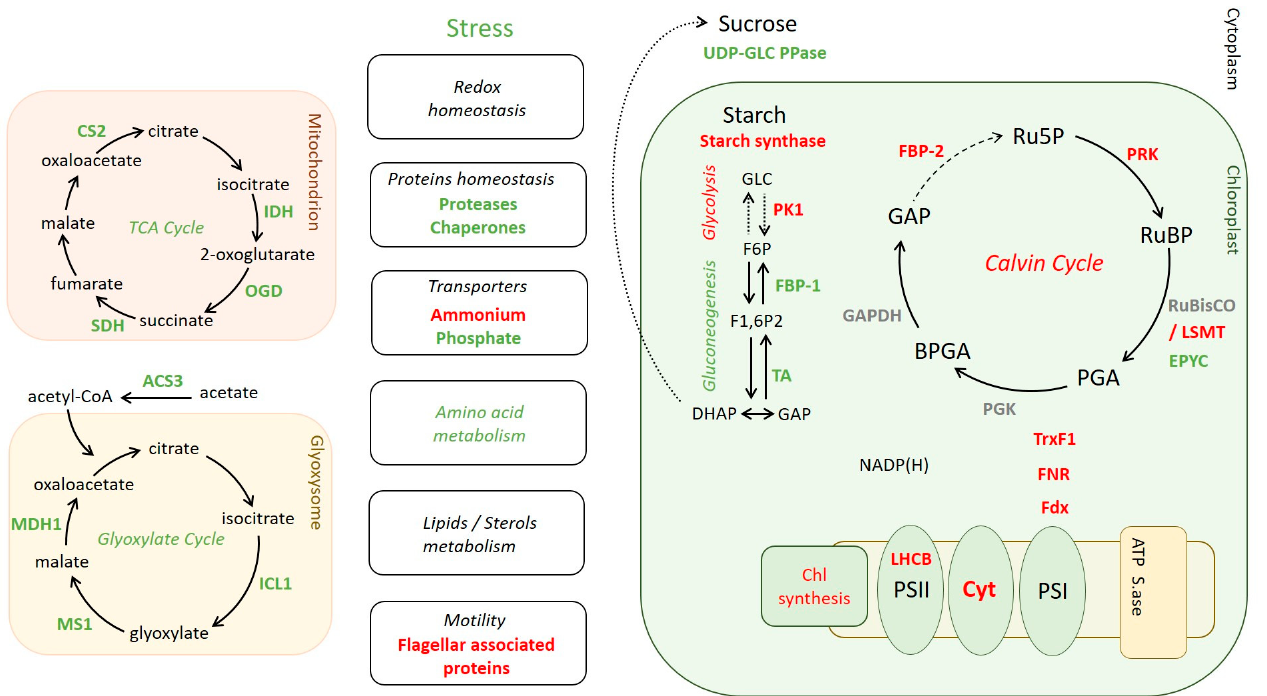
Figure 6. Effect of CP12 deletion on C. reinhardtii protein amounts. Green: higher amount in ∆ CP12-Cr compared to WT-Cr. Red: lower amount in ∆ CP12-Cr compared to WT-Cr. Gray: no change. LHCB, Light-harvesting chlorophyll a/b-binding; Cyt, Cytochrome b6 f; PS , photosystem; ATP S.ase, ATP synthase; Fdx, ferredoxin; FNR, Ferredoxin NADP + reductase; TrxF1, thiore- doxin F1; PGK, Phosphoglycerate kinase; BPGA, 1,3-bisphosphoglycerate; GAP, Glyceraldehyde − 3- phosphate; GAPDH, Glyceraldehyde − 3-phosphate dehydrogenase; PGA, 3-phosphoglycerate; FBP, Fructose − 1,6-bisphosphatase; Ru5 P, Ribulose 5-phosphate; PRK, phosphoribulokinase; RuBP, Ribulose − 1,5- bisphosphate; RuBisCO LSMT, RuBisCO large subunit methyltransferase; EPYC, essential pyrenoid component; UDP-GLC PPase, UDP-glucose pyrophosphorylase; PK1, Pyruvate kinase 1; TA, transaldolase; F6 P, fructose − 6-phosphate; F1,6 P2, Fructose − 1,6-bisphosphate; DHAP, Dihydroxyacetone phosphate; IDH, Isocitrate dehydrogenase; OGD, 2-oxoglutarate dehydrogenase; SDH, Succinate dehydrogenase; CS2, citrate synthase 2; ACS3, Acetyl-CoA synthetase 3; ICL1, Isocitrate Lyase 1; MS1, Malate synthase 1; MDH1, Malate dehydrogenase